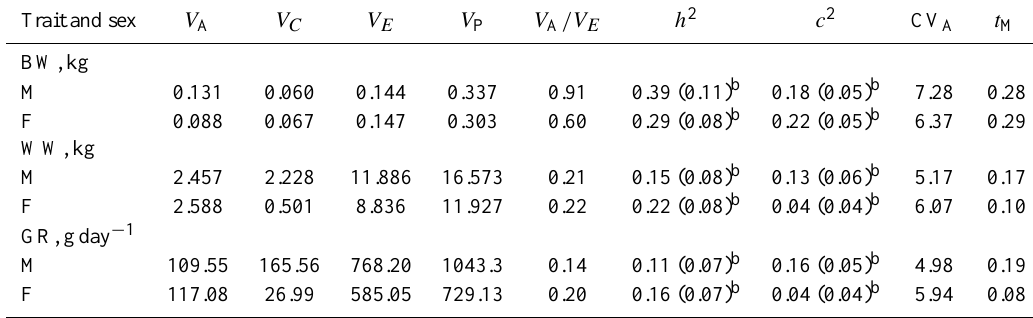
Table 6. Estimates of variance components and genetic parameters in male and female lambs. Trait and